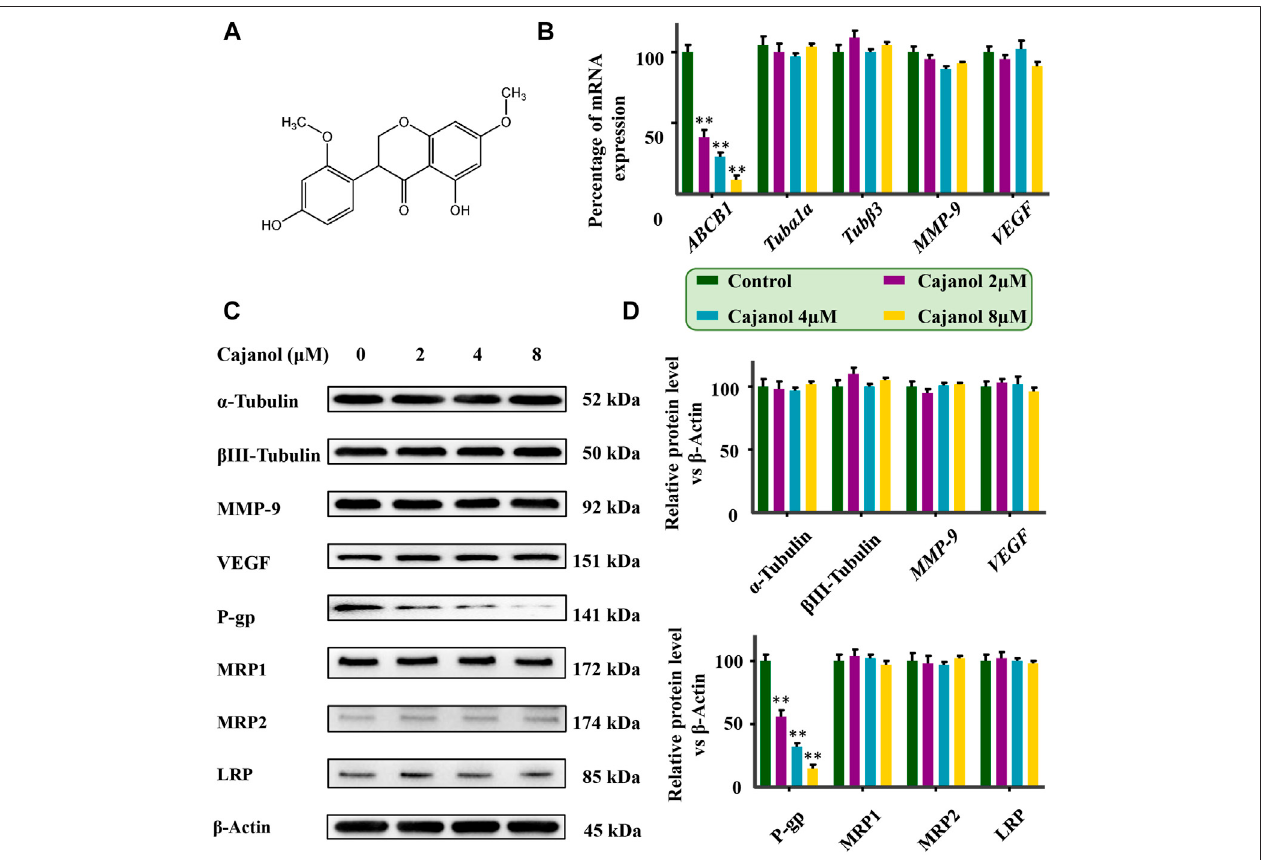
FIGURE 1 | Effect of cajanol on ABCB1 mRNA and P-gp protein expression in ovarian cancer cells. Cells were treated with cajanol (0, 2, 4 or 8 μ M) for 48 h. (A) Chemical formula of cajanol. (B) Effect of cajanol on ABCB1 , MMP-9 , VEGF , Tub α 1a and Tub β 3 mRNA expression in A2780/Taxol cells as determined by RT-qPCR assay. (C) Expression of α -tubulin, β III-tubulin, VEGF, MMP-9, P-gp, MRP1, MRP2 and LRP protein in A2780/Taxol cells after treated with cajanol. (D) Expression was normalized with ß -actin, respectively. Each column shows the mean ± S.D. * p < 0.05, ** p < 0.01 vs . control group.